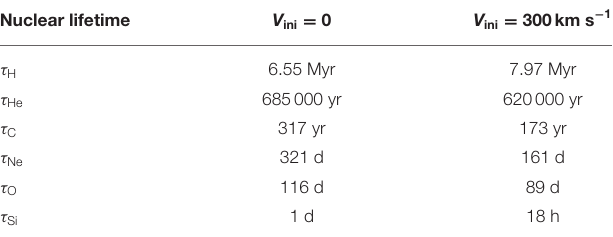
(from Hirschi et al., 2004 A&A, 425, 649, ⊙